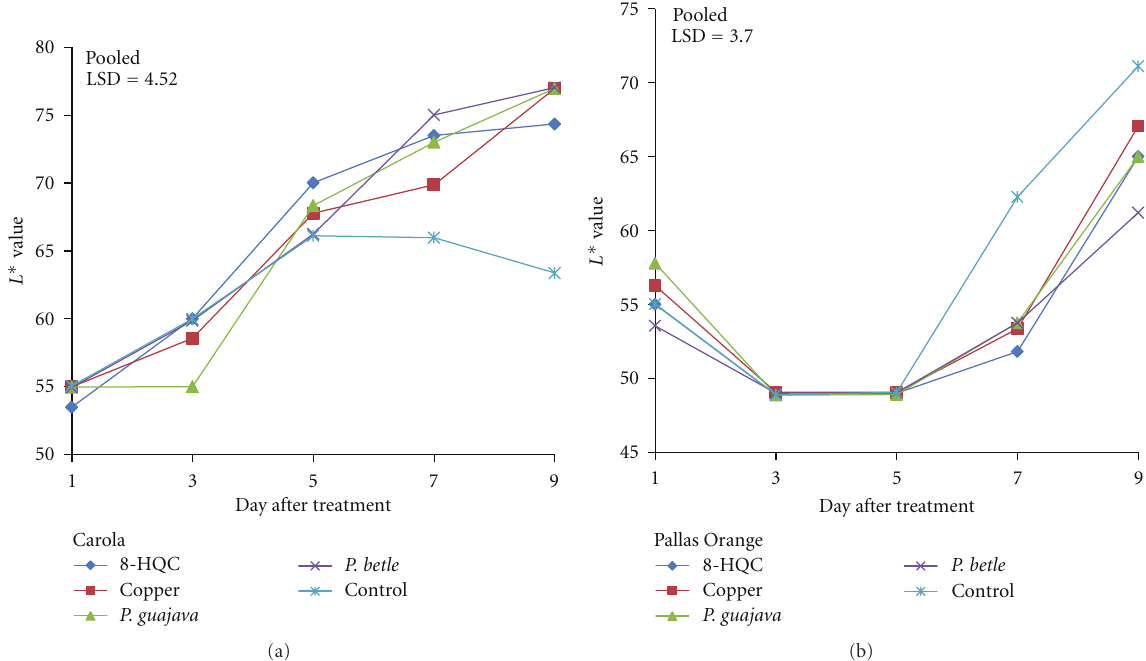
Figure 3: E ff ect of 8-HQC, copper coin, and leaf extracts of P. guajava and P. betle and control on L ∗ value of (a) “Carola” and (b) “Pallas Orange” cut carnation flowers.